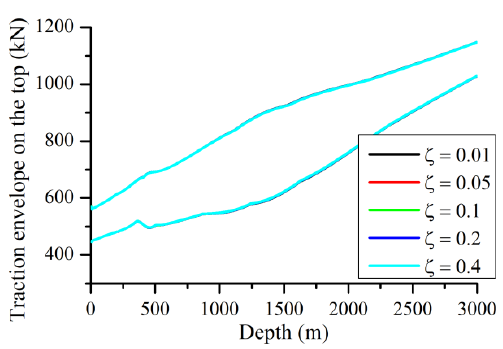
Figure 10. Influence of the damping ratio on the top traction.